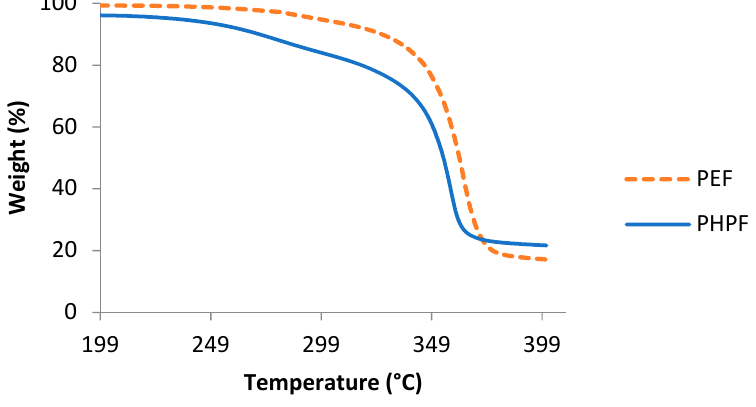
Figure 3. TGA traces curves of PEF and PHPF.